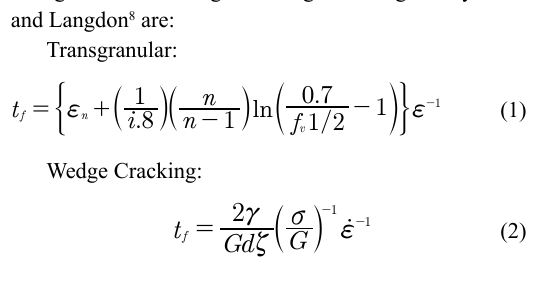
leads to the shortest time to fracture t